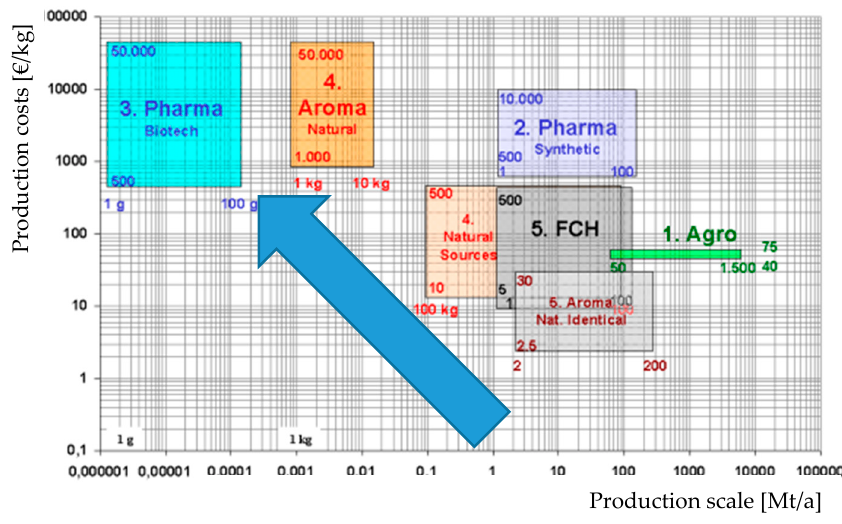
Figure 11. Dependency of production costs on the target market [130].